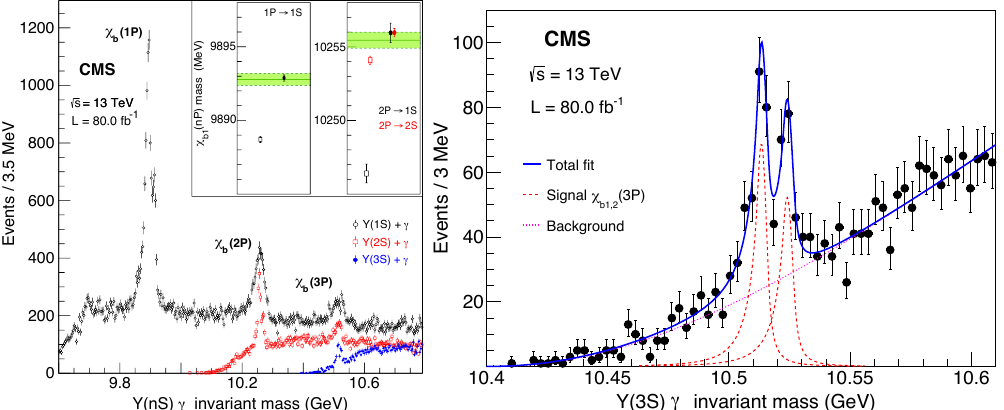
Figure 10. Invariant mass of the Υ ( nS ) γ system on the left, with a peak corresponding to χ b (3P), and on the right is the distribution of the invariant mass of the Υ ( 3 S ) γ system around the χ b (3P) mass